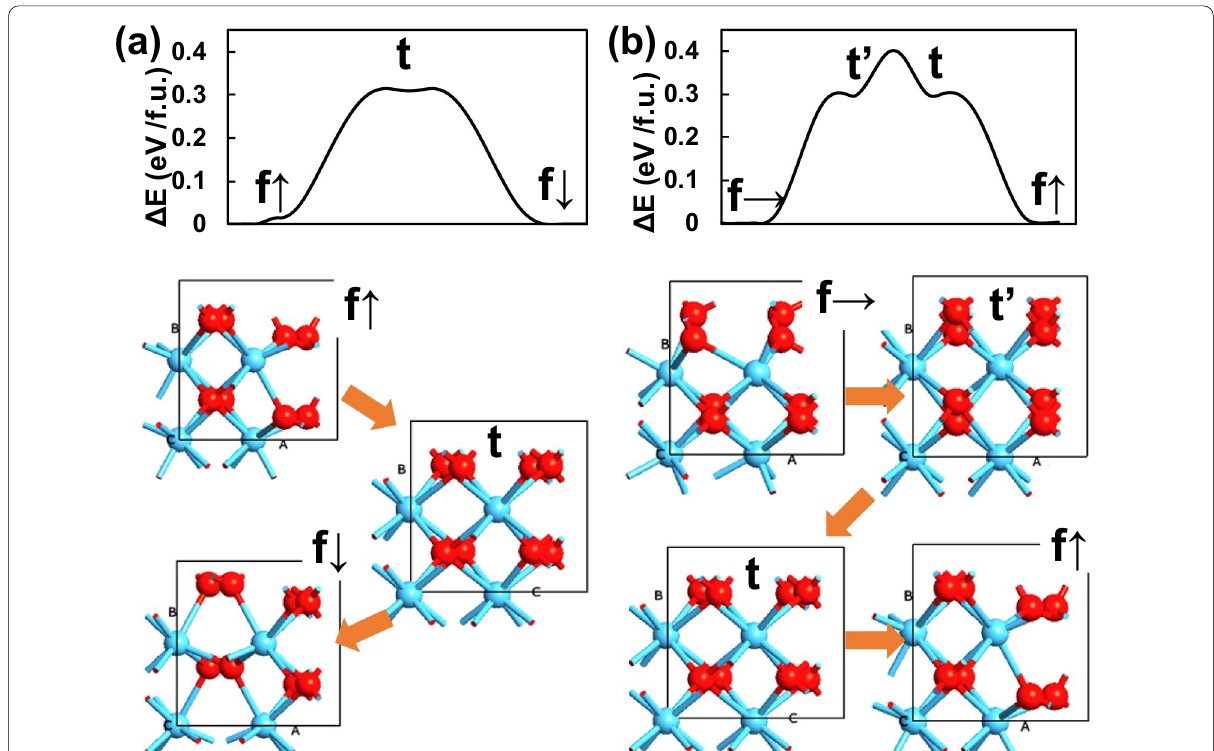
Fig. 10 Calculated kinetic pathway of ( a ) up/down polarization switching and ( b ) in-plane/out-of-plane polarization transition via t-phases as intermediate